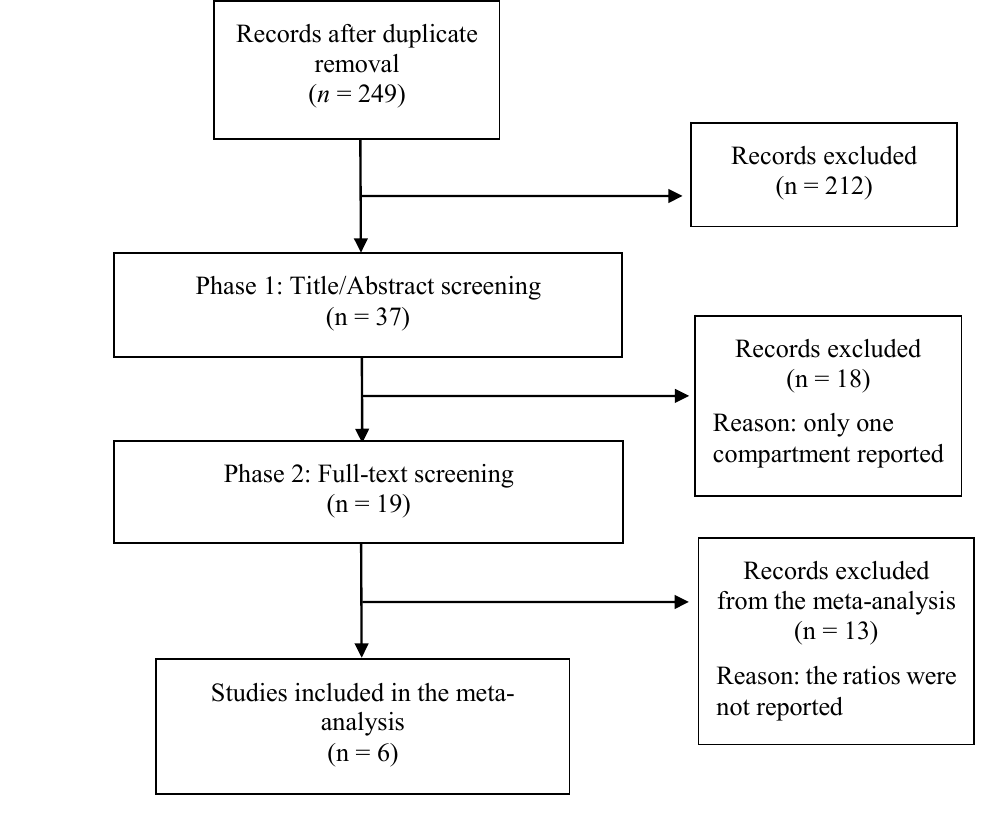
Figure 1. PRISMA flowchart of search strategy and study selection with exclusion criteria.